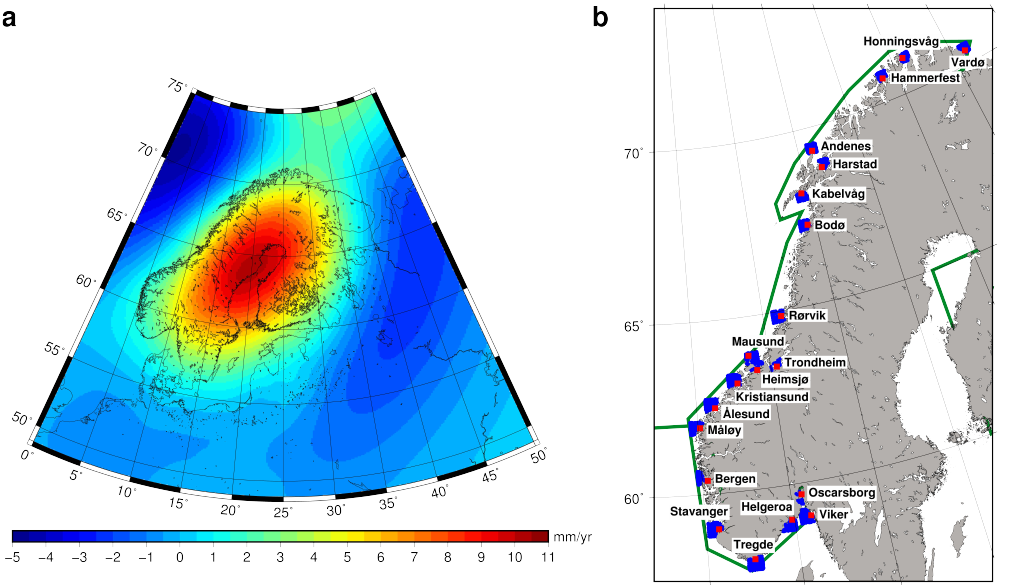
Figure 1. ( a ) The absolute land-uplift model for the Nordic-Baltic region NKG2016LU_abs [11] in ITRF2008. ( b ) Blue dots indicate available CS2 SARIn observations in 45 km × 45 km CS2 boxes around 20 Norwegian tide gauges. Red squares indicate the tide-gauge locations (see Supplementary Materials Table S1). The green line shows the CS2 SARIn-mode border, using the geographical mode mask version 3.9